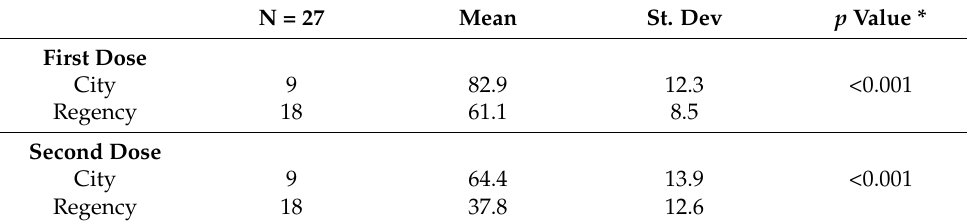
Table 3. Statistical analysis of total vaccination coverage based on regional status (%). N = 27 Mean St. Dev p Value